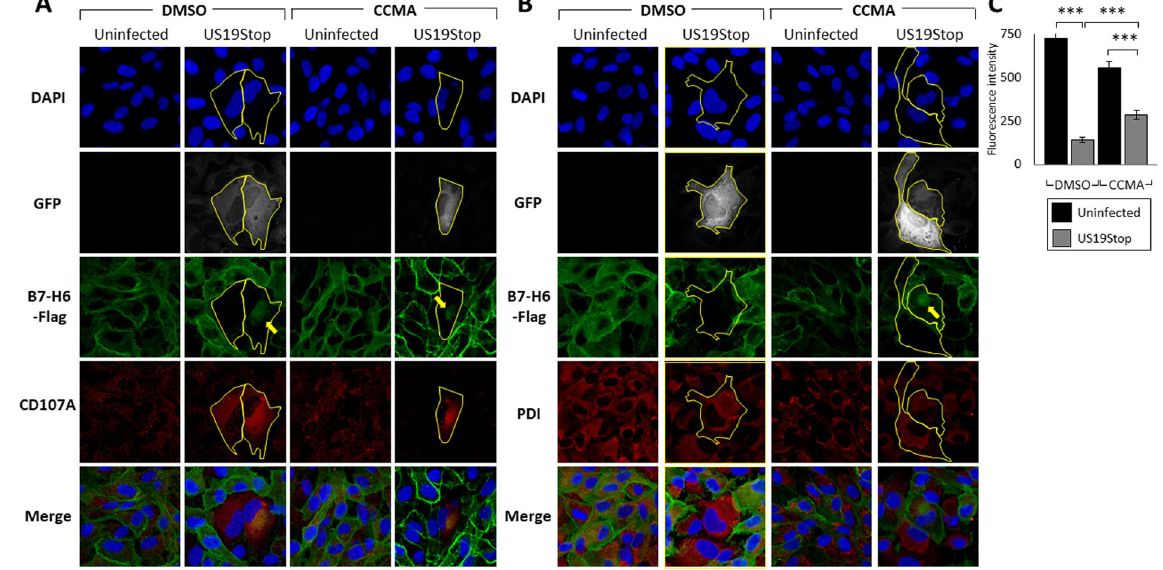
Figure 5. Downregulation of B7-H6 during HCMV infection is mediated through lysosomal degradation. ( A ) ARPE19 cells overexpressing B7-H6-FLAG were infected with HCMV US19Stop or left uninfected, and were treated with 50 nM Concanamycin A (CCMA) or left untreated (DMSO). The cells were then stained with DAPI and antibodies against the FLAG-tag or the lysosomal marker CD107A, and visualized using confocal microscopy. GFP marks infected cells. Infected cells boundaries are marked by a yellow line. Yellow arrows mark intracellular accumulations of B7-H6-FLAG. ( B ) ARPE19 cells overexpressing B7-H6-FLAG were infected with HCMV US19Stop or left uninfected, and were treated with 50 nM Concanamycin A (CCMA) or left untreated (DMSO). The cells were then stained with DAPI and antibodies against the FLAG-tag or the ER marker PDI, and visualized using confocal microscopy. GFP marks infected cells. Infected cells boundaries are delineated using a yellow line. Yellow arrows mark intracellular accumulations of B7-H6-FLAG. ( C ) Quantification of the FLAG-tag fluorescence intensity shown in A. Averages of 45–85 cells from each category are presented, error bars represent standard error of the mean. A student’s t test was performed in order to evaluate significance. *** p-value <